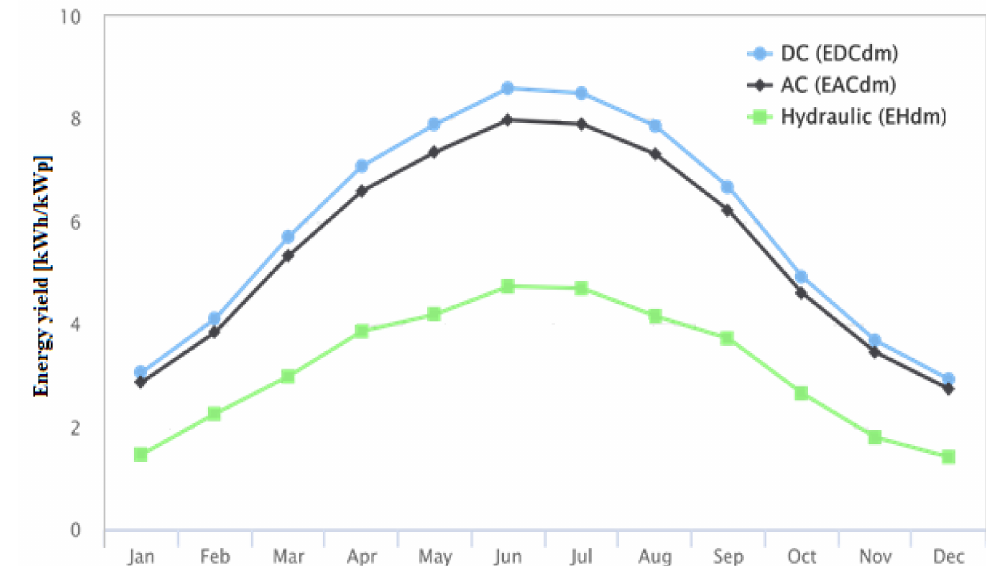
Figure 13. Monthly energy yield of the PV pumping system (Antalya,